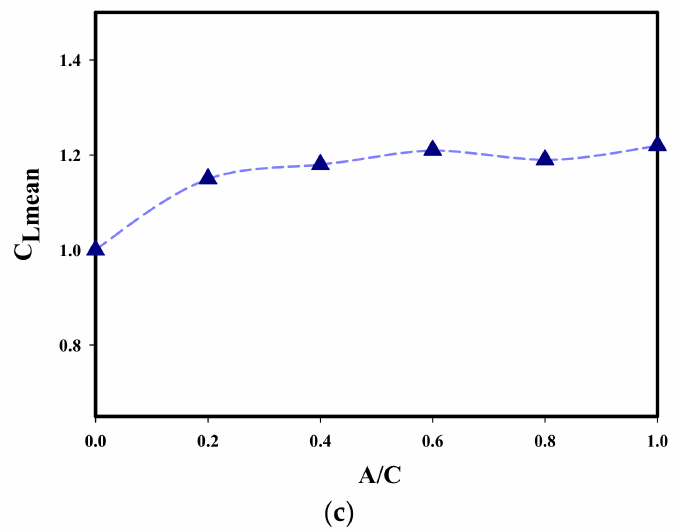
Figure 14. Variations in aerodynamic coefficients after applying flow control: ( a ) variations in the lift coefficient fluctuations, ( b ) variations in the mean drag coefficient, ( c ) variations in the mean lift coefficient for airfoil.